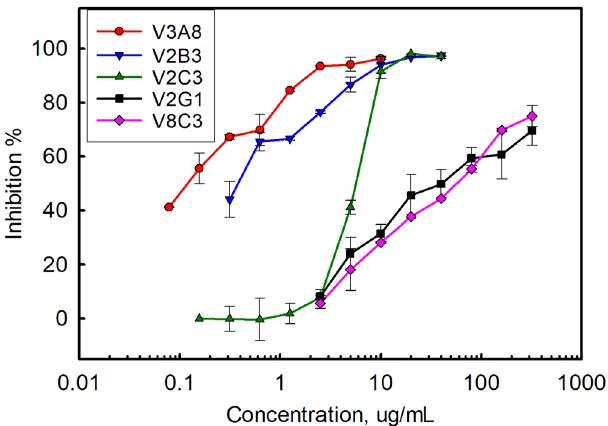
Figure 2. PRNT of representatives from each of the five anti- VEEV-TC-83 families. Data is shown from a representative set of neutralization experiments performed in duplicate. Error bars represent the standard error.